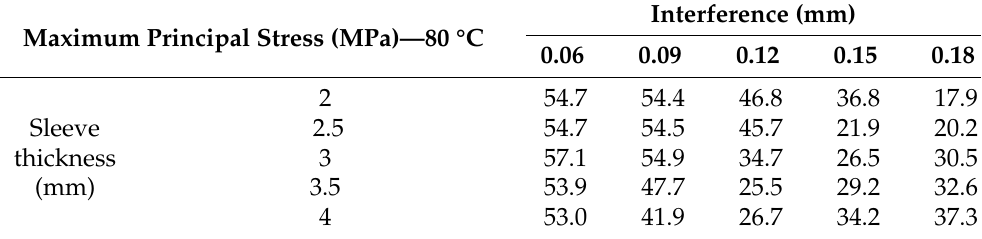
Table 5. The maximum principal stress results at different sleeve thickness and interference (80 °C).